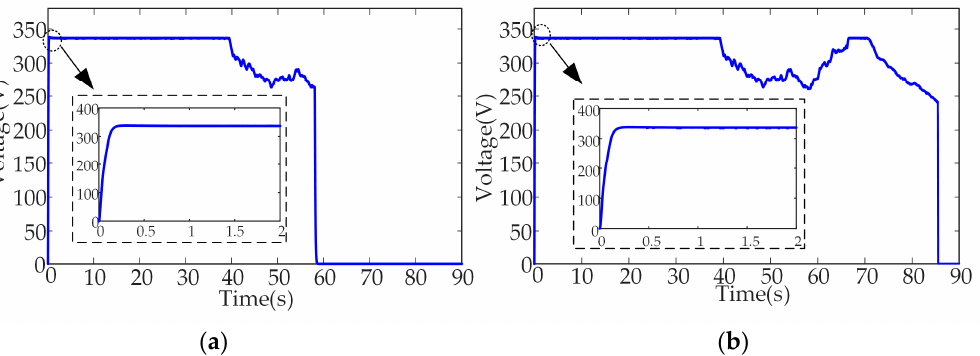
Figure 20. The phase voltage waveforms under irregular incident waves. ( a ) Phase voltage of G1; ( b ) phase voltage of G2.